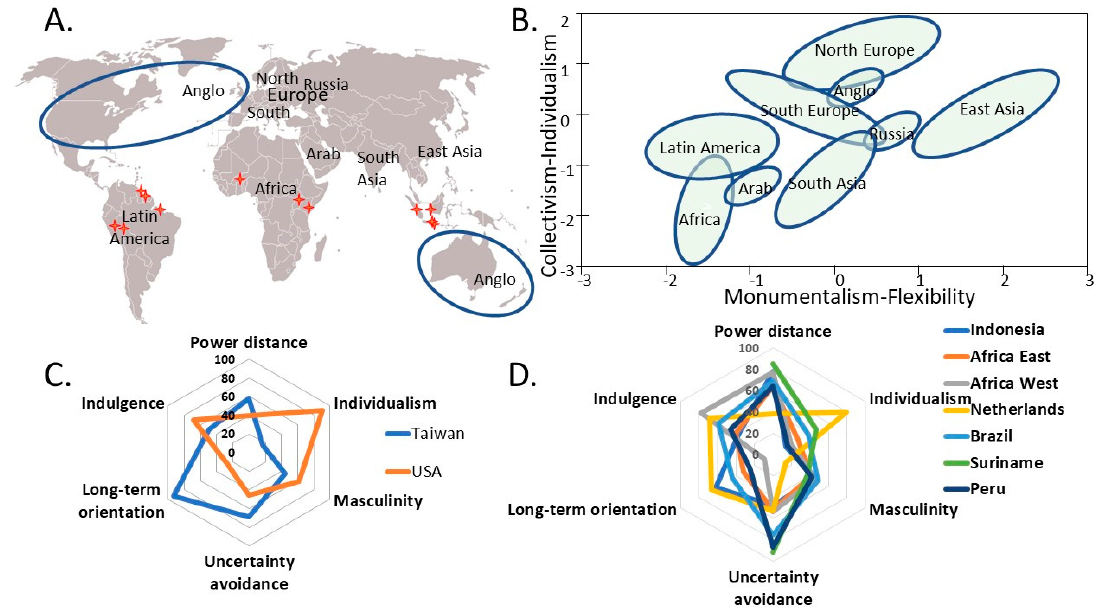
Figure 9. Geography of cultural dimensions: ( A ) Global map with red signs indicating landscapes where SESAM is active; ( B ) Two main axes of cultural variation and the relative position of countries (based on national surveys) and country groupings [52]; ( C ) Comparison of six Hofstede dimensions for two contexts in which the ‘so long sucker’ game was played; ( D ) Hofstede dimensions for the countries (or where such data are lacking regions) involved in SESAM [53].